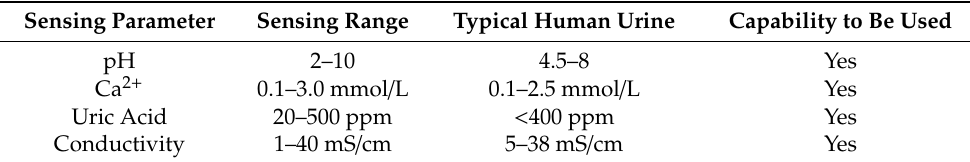
Table 2. Testing range of the system vs. typical human urine